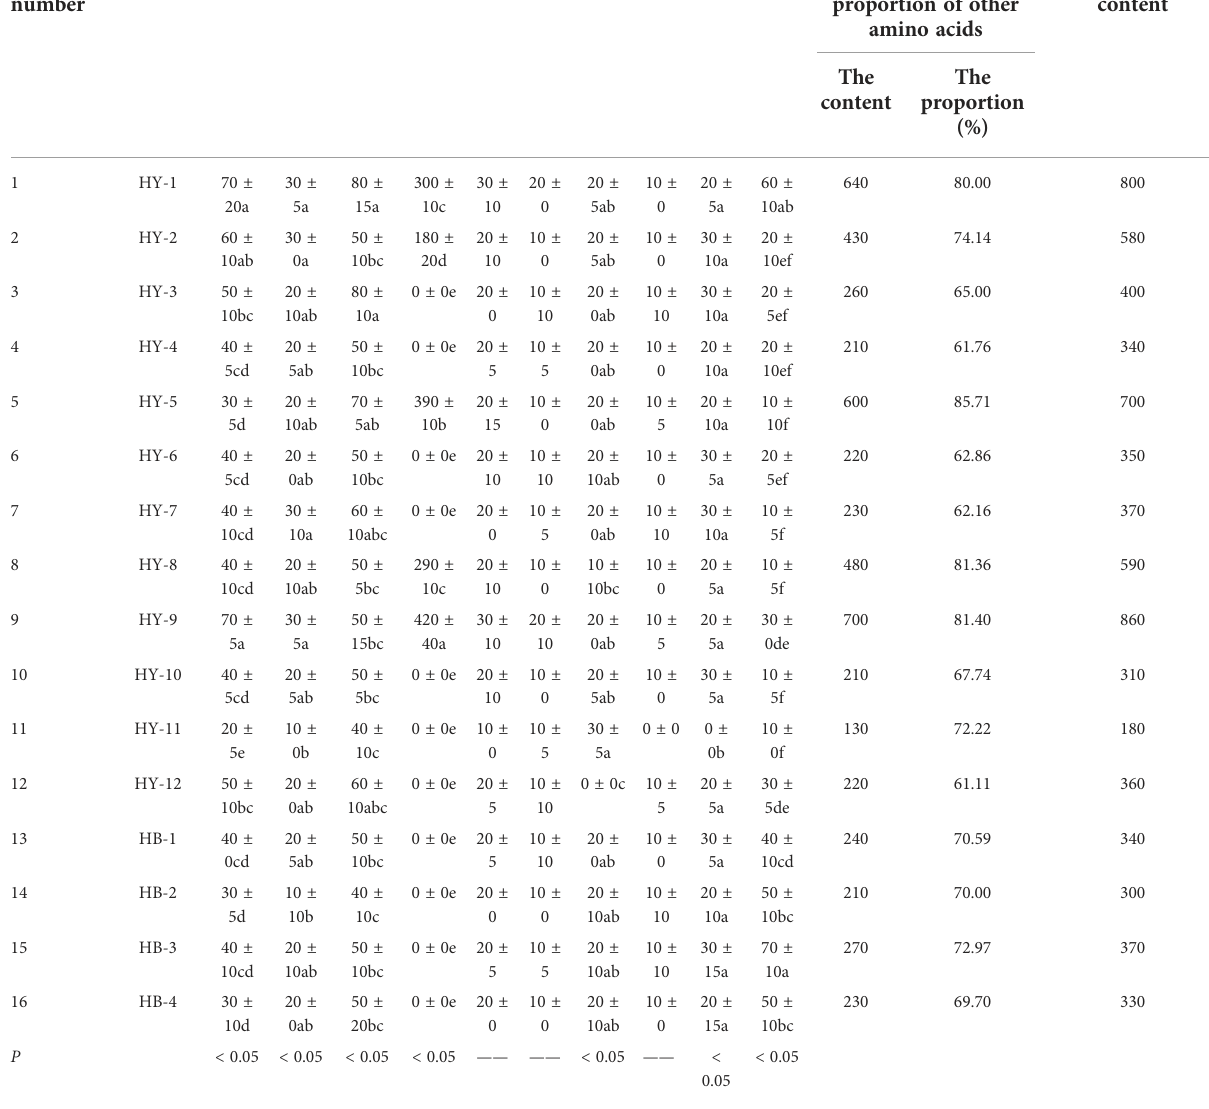
TABLE 5 The content of other amino acids in the pulp of different genotypes of A. trifoliata fruit(mg/100g). Serial Material number